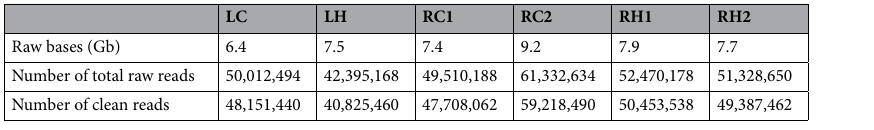
Table 2. Summary of